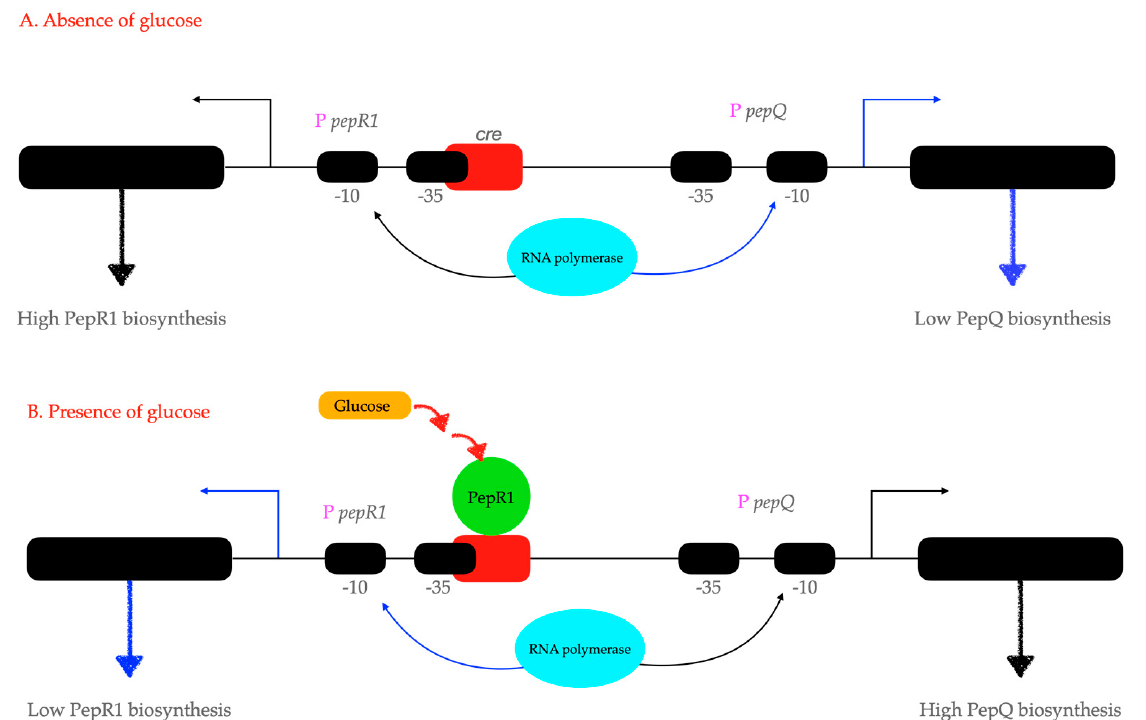
Figure 6. Mechanism of biosynthesis regulation of PepQ by PepR1 in L. bulgaricus in the absence of glucose ( A ) or in the presence of glucose ( B ). Glucose regulates production of PepQ through the binding of PepR1 to the single catabolite-responsible element ( cre ) box, which partly overlaps the − 35 position of the PepR1 promoter (P pepR1 ) and which is located 16 nt upstream of the PepQ promoter (P pepQ ). The position of the cre box target with regard to both promoters is essential for the inhibitory or stimulatory transcriptional effect resulting from the PepR1 binding. Image designed according to information extracted from Morel et al.